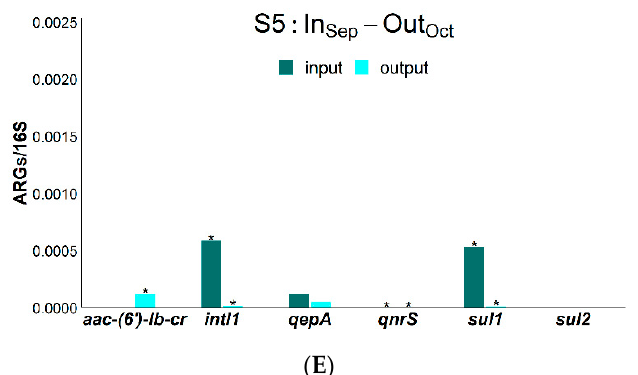
Figure 3. Relative gene abundances (ARGs/16S) found in ( A ) S1, ( B ) S2, ( C ) S3, ( D ) S4 and ( E ) S5 samplings (S1: In Feb - Out Apr ; S2: In Apr -Out Jun ; S3: In Jun -Out Jul ; S4: In Jul -Out Sep ; S5: In Sep -Out Oct ). Significant differences ( t -test, p < 0.05) are marked with*.